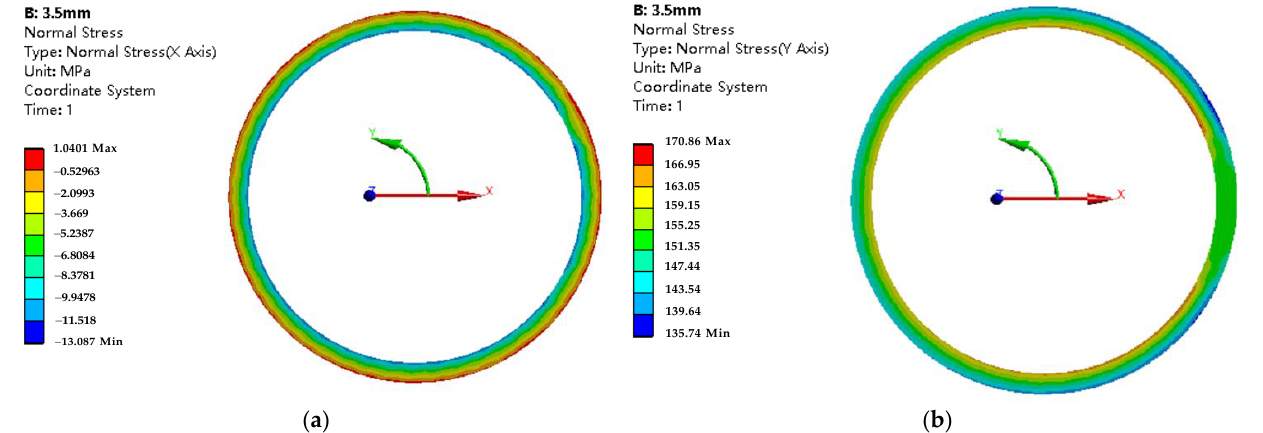
Figure 8. Stress results of the Titanium alloy sleeve with 3.5 mm: ( a ) the sleeve stress in the radial direction (X-Axis); ( b ) the sleeve stress in the tangential direction (Y-Axis).